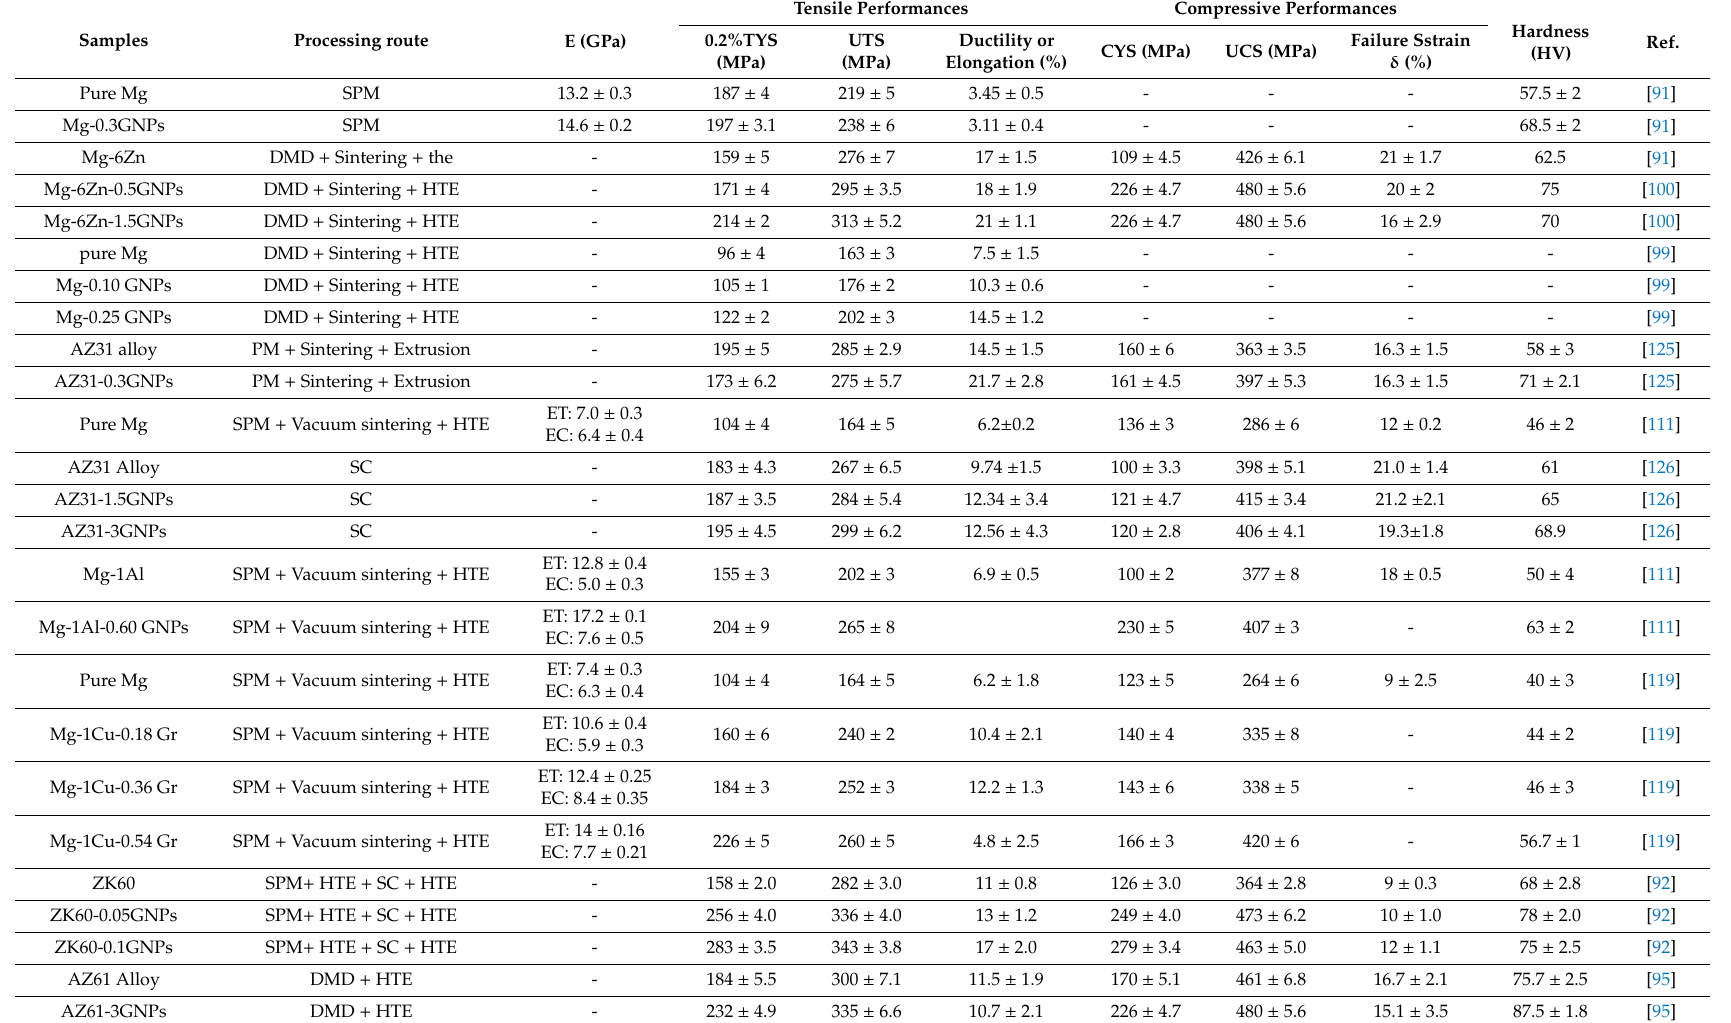
Table 2. Mechanical properties of Mg-based nanocomposites containing